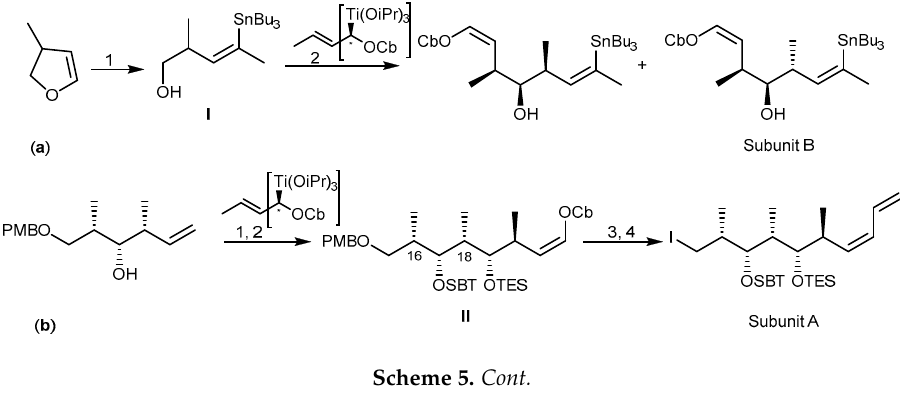
Figure 6. Structure of discodermolide ( 29 ) with highlighted subunits A, B, and